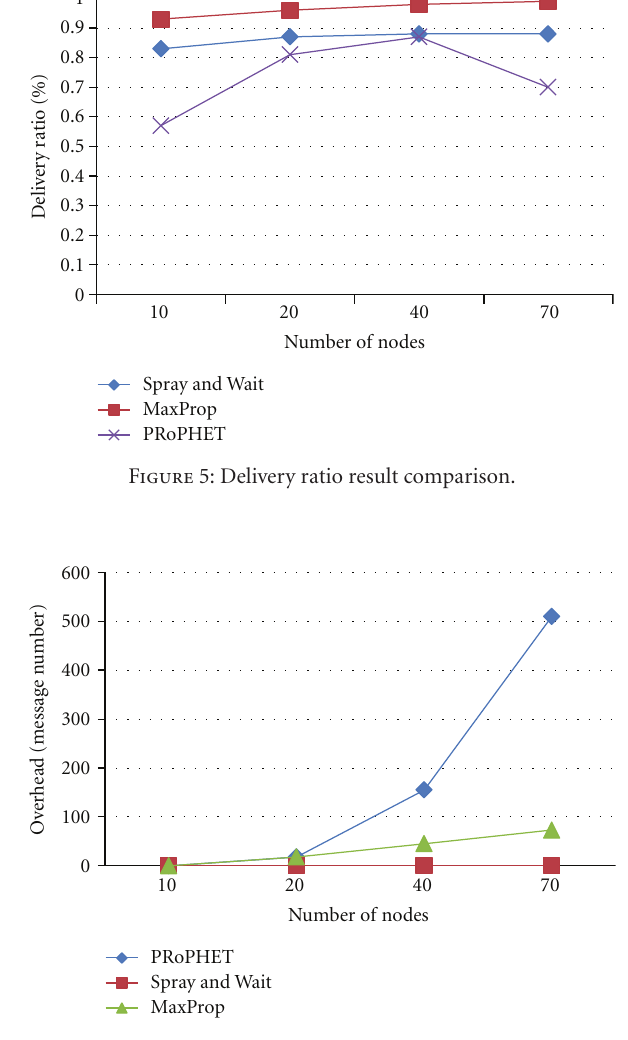
Figure 6: Communication overhead result comparison.